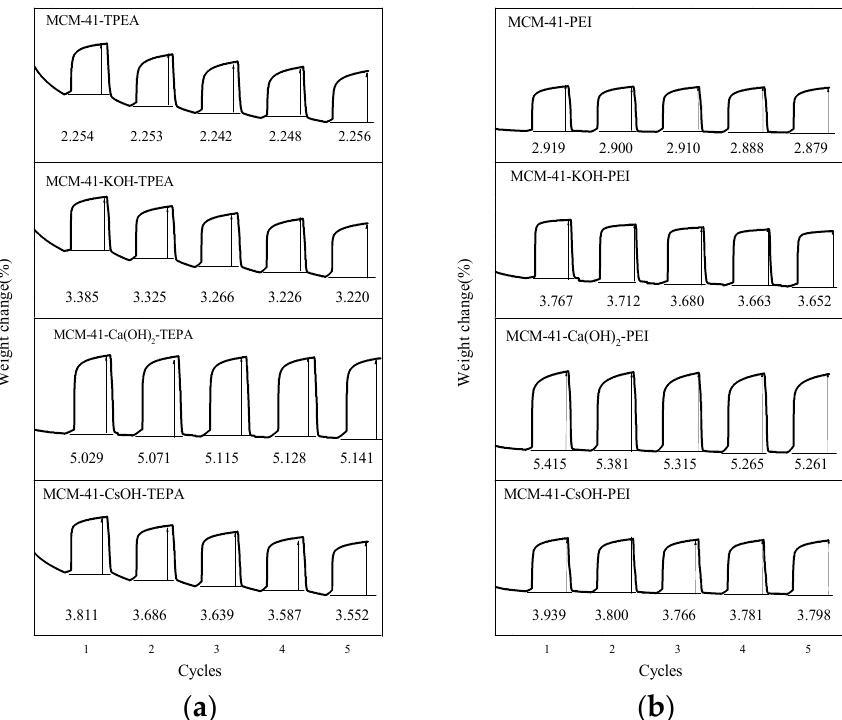
Figure 6. Cycle adsorption/desorption performance of ( a ) TEPA ( b ) PEI and various inorganic alkali modified adsorbents.